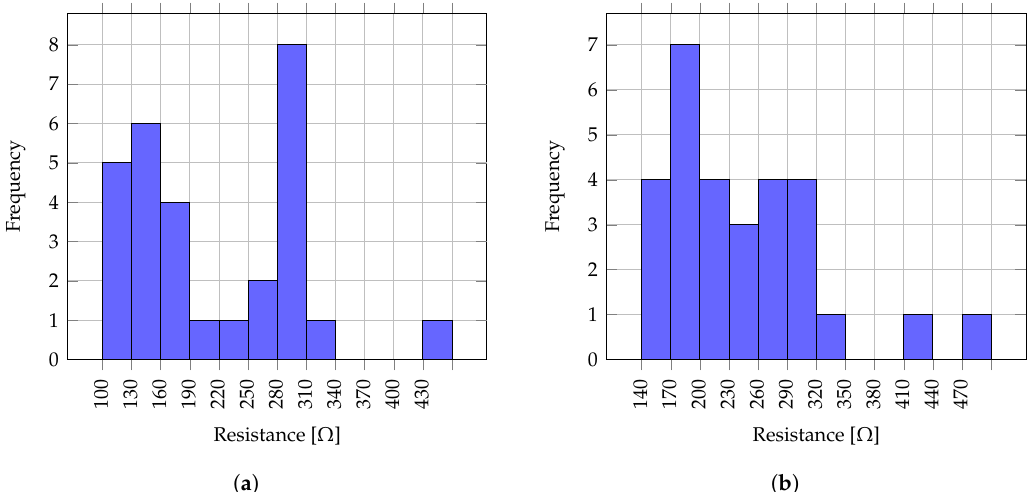
Figure 7. Histogram of resistances from 29 samples of carbon temperature sensors type 1 ( a ) and 2 ( b